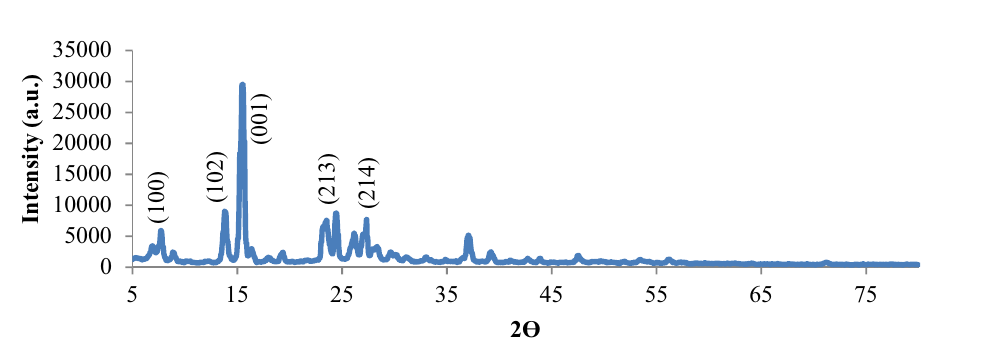
Figure 4. XRD pattern of